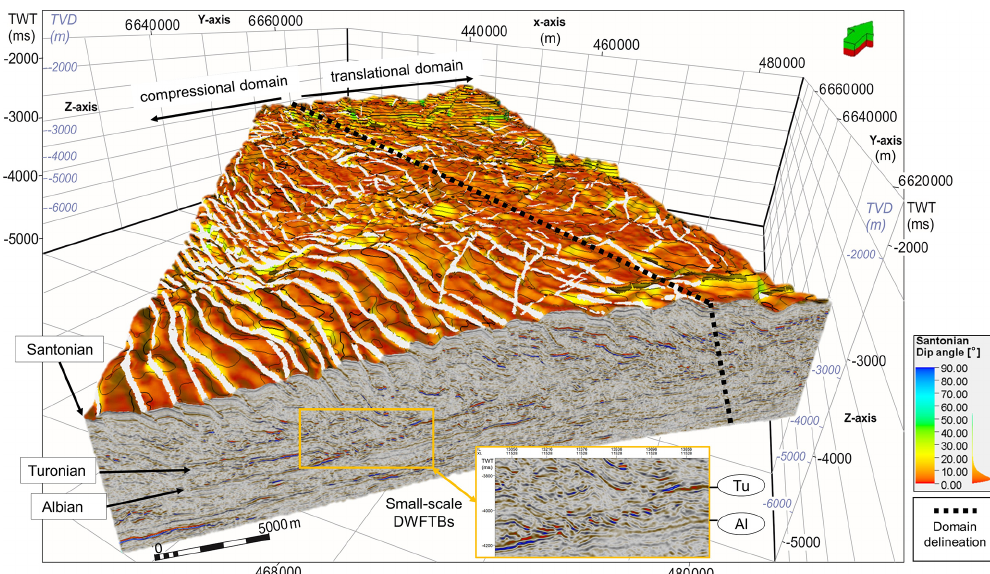
Figure 9. Three-dimensional view of a crossline showing an extensive, kilometre-scale DWFTB system detaching the Turonian slip surface, the Santonian horizon (in dip angle) defining the crest of the large folds, and an underlying localized set of secondary, small-scale DWFTBs upon the Albian slip surface. Vertical exaggeration: